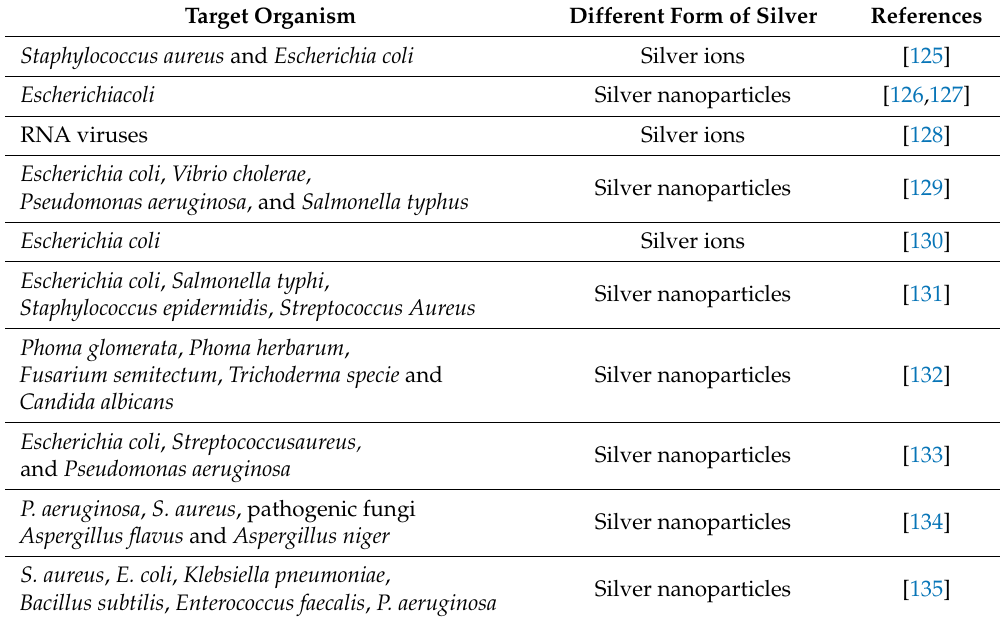
Table 1. Activity of Ag + and/or AgNPs against selected bacterial strains. Adapted from [124], with permission from John Wiley and